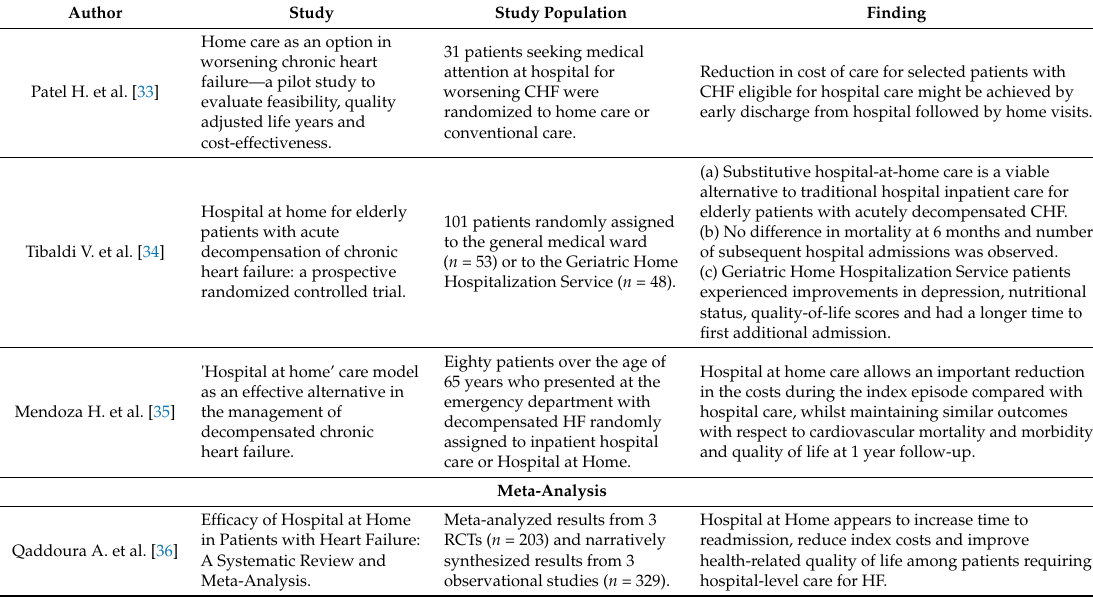
Table 1. Synopsis of main studies investigating home-based care programs for heart